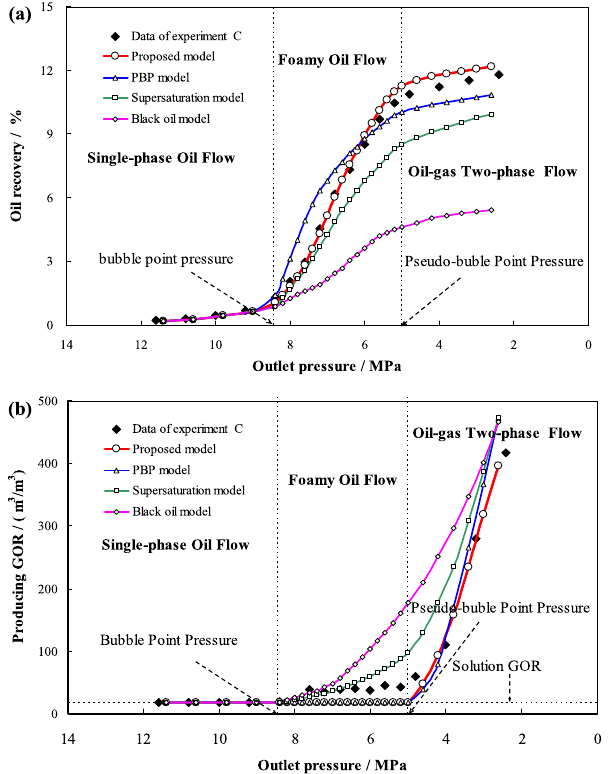
Figure 6. The simulated results by the four models in comparison with the experimental data for experiment C. ( a ) Oil recovery with respect to outlet pressure. ( b ) Production GOR with respect to outlet